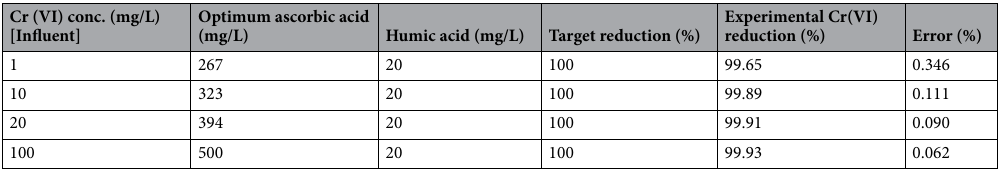
Table 4. Optimized reduction of Cr(VI) in water.